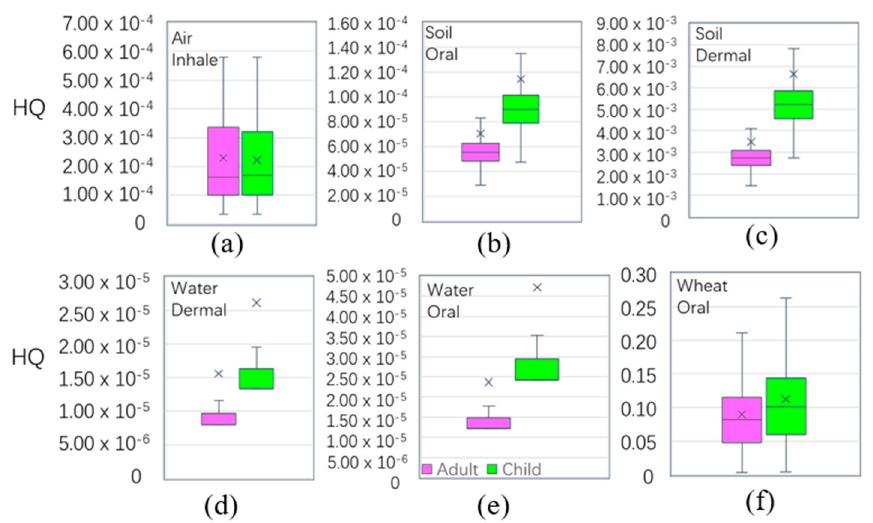
Figure 7. Boxplot of non-carcinogenic risk (hazard quotient) among the different exposure pathways (hazard quotient (HQ) is unitless).